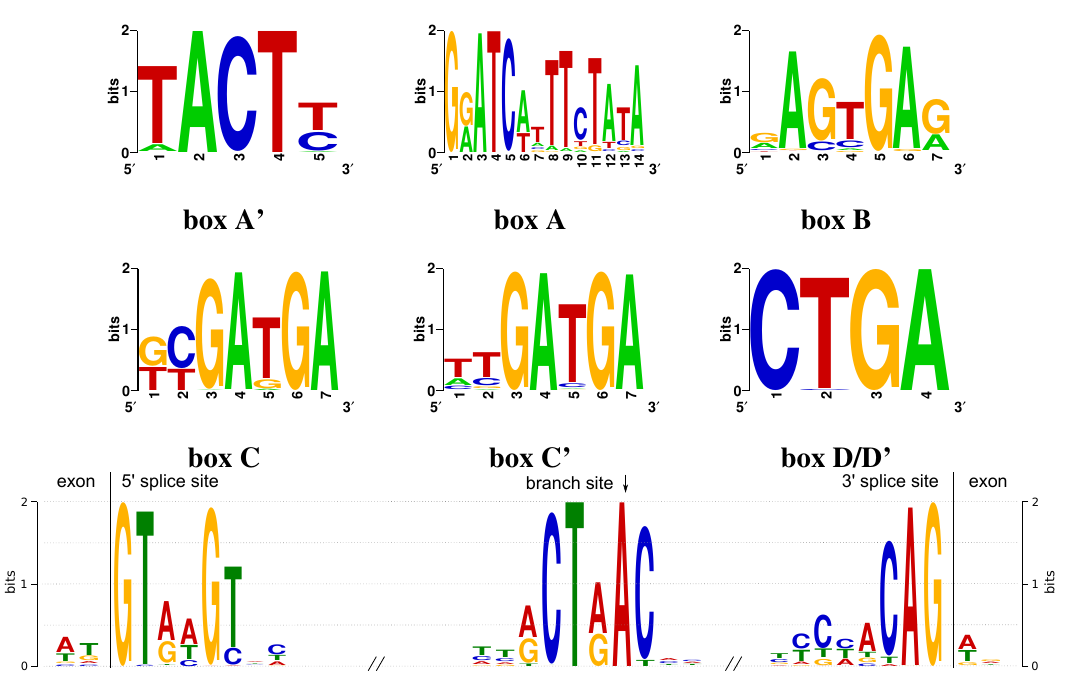
Figure A1. Sequence logos of conserved sequence elements in U3 snoRNAs ( above ) and in introns located in U3 snoRNA genes ( below ). All motifs were inferred with meme from all available U3 RNAs and introns, resp. The exact position of the splice junctions are